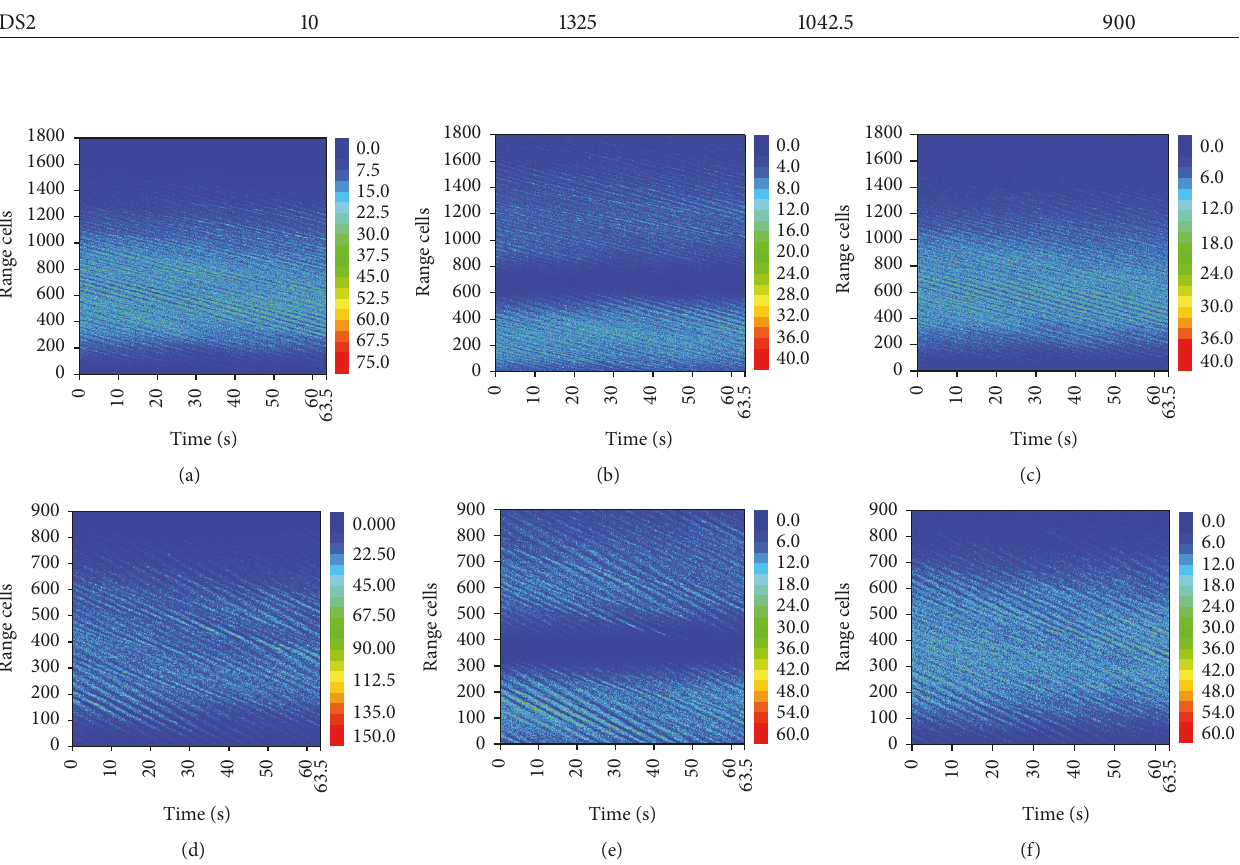
Figure 2: Sea clutter image in range against time format: ((a)–(c)) sum channel and elevation and azimuth difference channels for DS1. ((d)-(e)) Sum channel and elevation and azimuth difference channels for